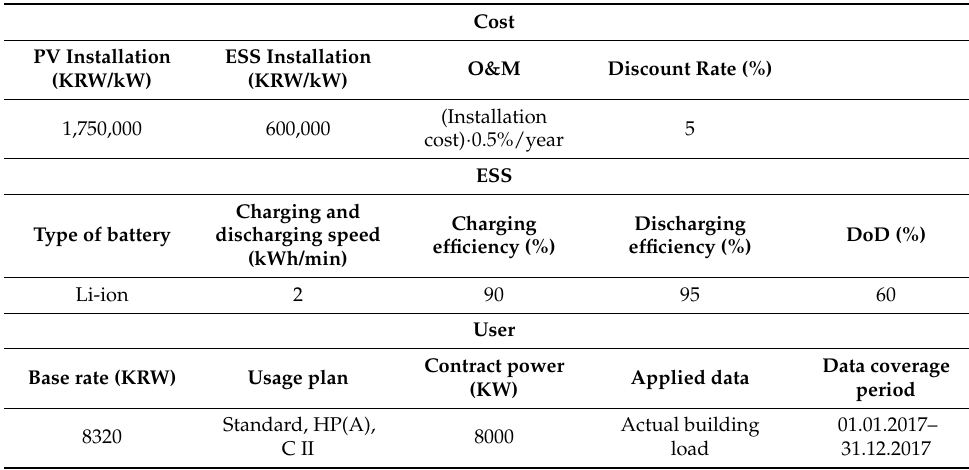
Table 7. Basic application factors for case study.